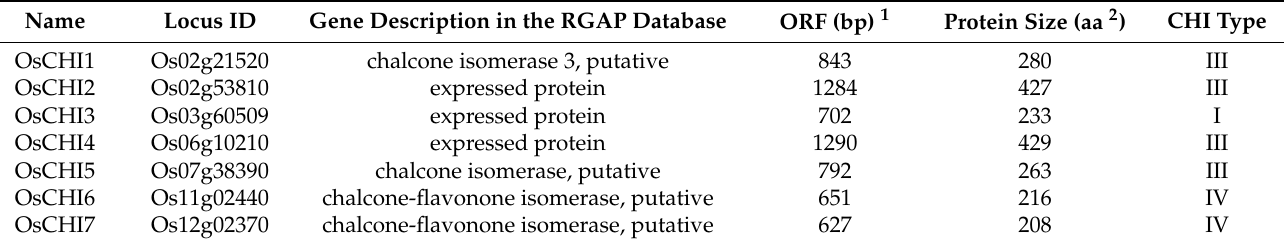
Table 1. Rice chalcone isomerase ( CHI ) gene